Question: Name the type of graph shown.
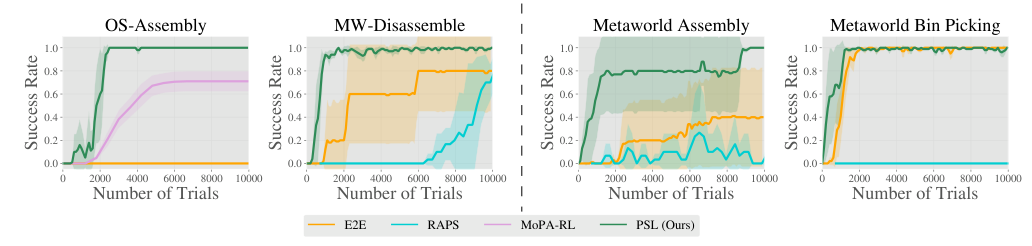
Answer: line